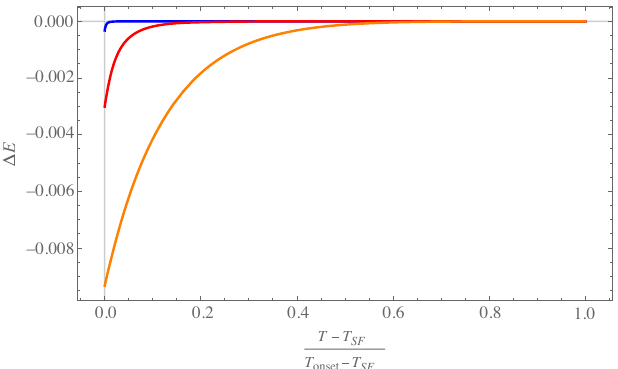
FIG. 17. The energy excess Δ E ¼ yf ð q 0 Þ − β f ð q 12 Þ as a = ð T − T function of the reduced temperature ð T − T SF Þ onset SF Þ for a ¼ 0 . 5 (orange), 0.9 (red), and 0.99 (blue), from bottom to top. According to the phase diagram shown in Fig. 14, the − T normalizing factor ð T remains finite in the a → 1 − onset SF Þ limit, but Δ E → 0 in that limit. For a ≲ 1 , Δ E is different from zero only very close to T SF